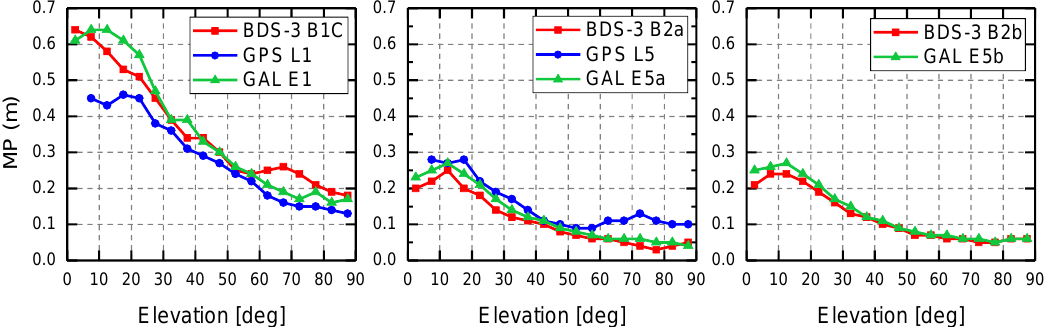
Figure 5. RMS of the noise and multipath errors as a function of satellite elevation for the signals with overlapping frequencies of BDS-3, GPS, and Galileo at HMNS station. The signals include B1C/L1/E1 ( a ); B2a/L5/E5a ( b ); and B2b/E5b ( c ).